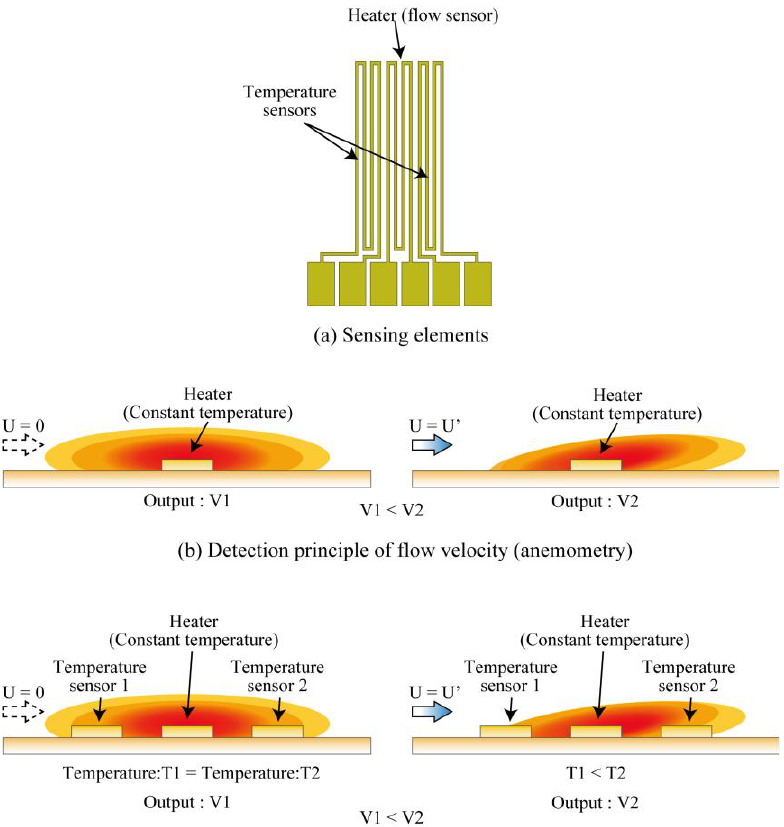
Figure 5. Schematic of the proposed flow sensor. Development of the sensing element fabricated on a COP substrate ( a ). The substrate deformed into a tube structure ( b ).